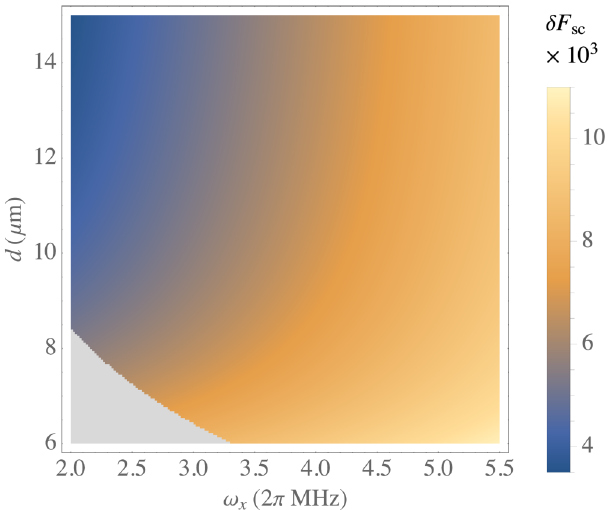
FIG. 12. Spontaneous scattering infidelity for parallel gates performed on 24 Mg + ground-state qubits with 400-nm tweezer wavelength for varying ion distance d and radial trap frequency ω (cid:14) is fixed, and ν ω 0 is determined in x . By choosing d and x , order to reach the strong pinning regime. The gray region marks parameter combinations that lead to a zigzag configuration of the ion